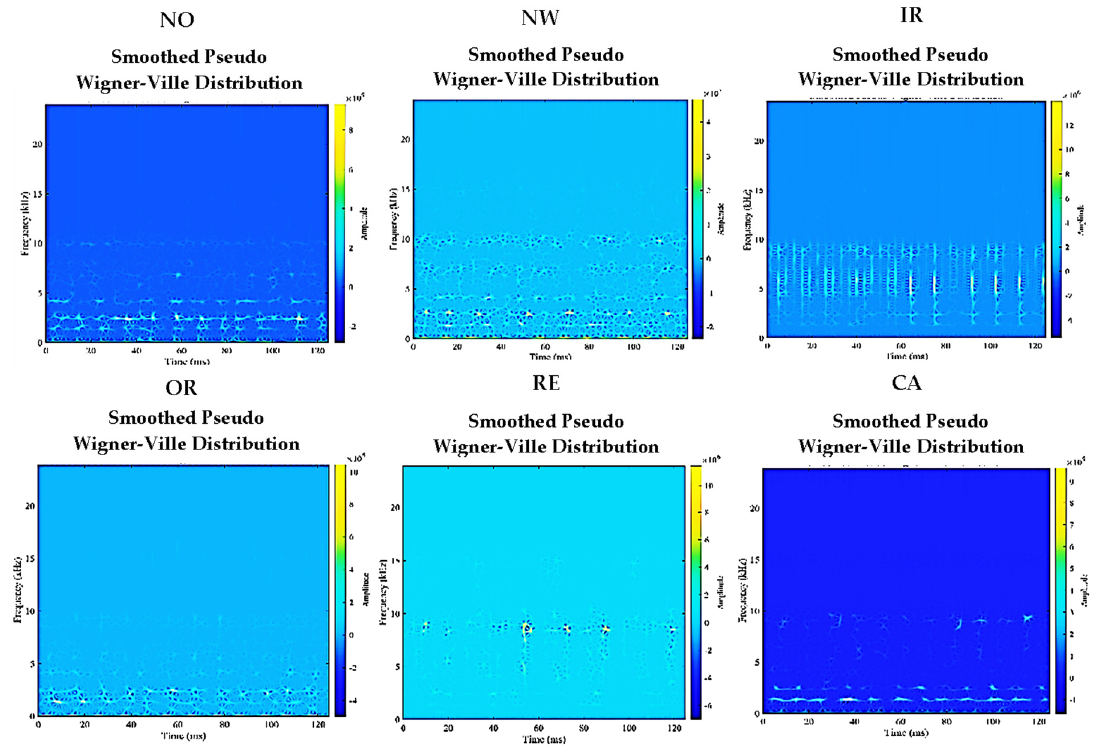
Figure 24. Examples of the computed smoothed pseudo WVD of bearing vibration signals with six different health conditions that were described in Section 2.1.1 above.